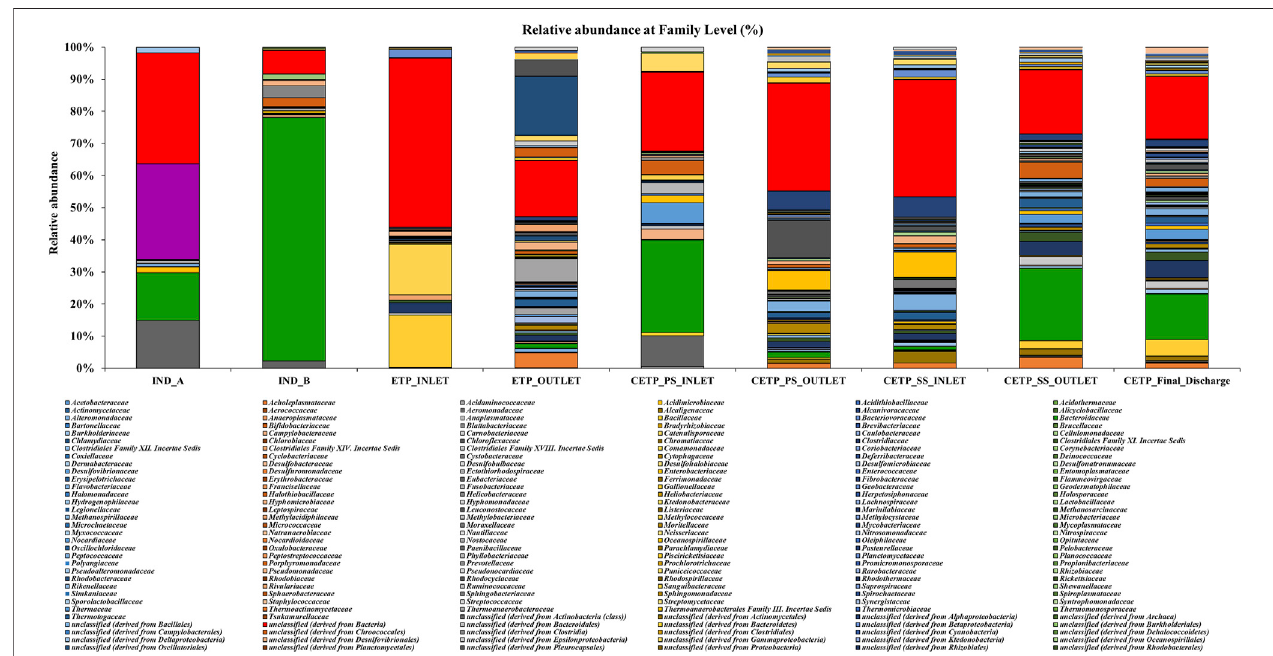
FIGURE 3 | Relative abundance (%) of the microbial diversity at the family level of the different textile industry ef fl uent metagenome samples highlighting the dominance of the Shewanellaceae, Enterobacteriaceae, Bacteroidaceae, Aeromonadaceae, and Pseudomonadaceae in the industry samples (IND_A and IND_B). Comamonadaceae, Bacillaceae, Nostocaceae, and Burkholderiaceae were dominant in ETP inlet samples. Bacteroidaceae, Desulfovibrionaceae, Aeromonadaceae, Enterobacteriaceae, Campylobacteraceae, Vibrionaceae, Flavobacteriaceae, and Alcaligenaceae were dominant in the CETP primary stage treatment sites. In contrast, Alcaligenaceae, Pseudomonadaceae, Flavobacteriaceae, Burkholderiaceae, Bacteroidaceae, and Clostridiaceae were families higher in abundance at CETP secondarystagesites.Thedominantfamiliesatthe fi nalstage(CETP_Final_Discharge)siteswereBacteroidaceae,Alcaligenaceae,Clostridiaceae,Desulfovibrionaceae, Enterobacteriaceae, Pseudomonadaceae, and